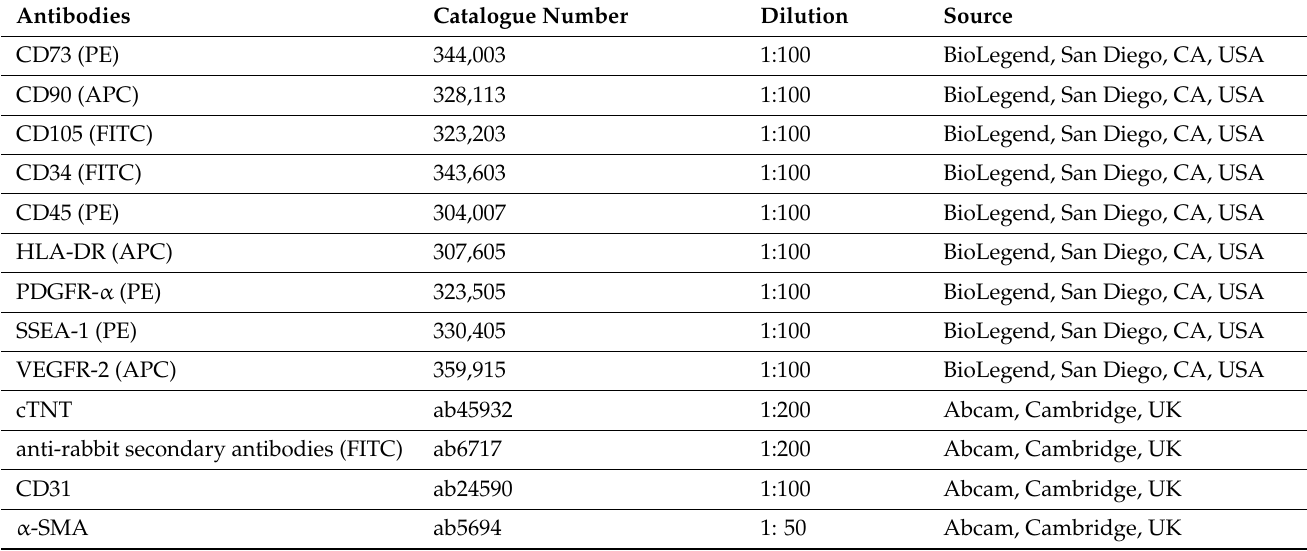
Table 1. List of antibodies with their